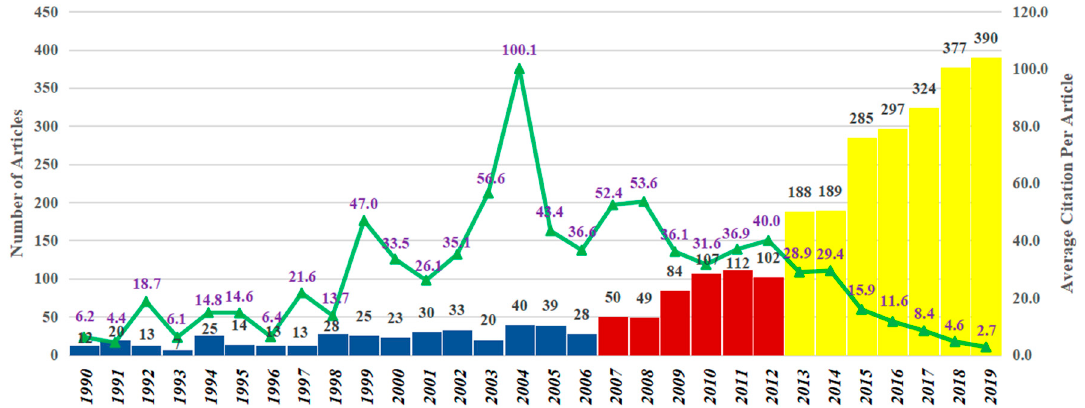
Figure 2. Food security research articles published from 1990 to